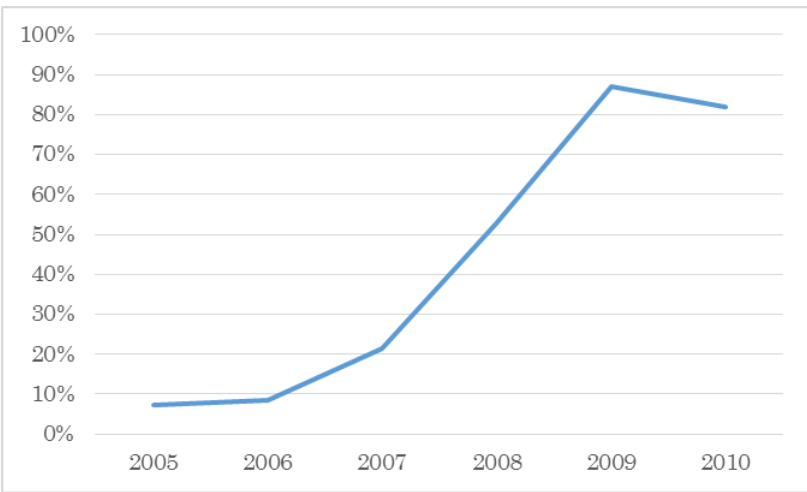
Figure 1. Diffusion rate of TV function Note: Diffusion rate is calculated by number of samples with TV functionality divided by all samples from each